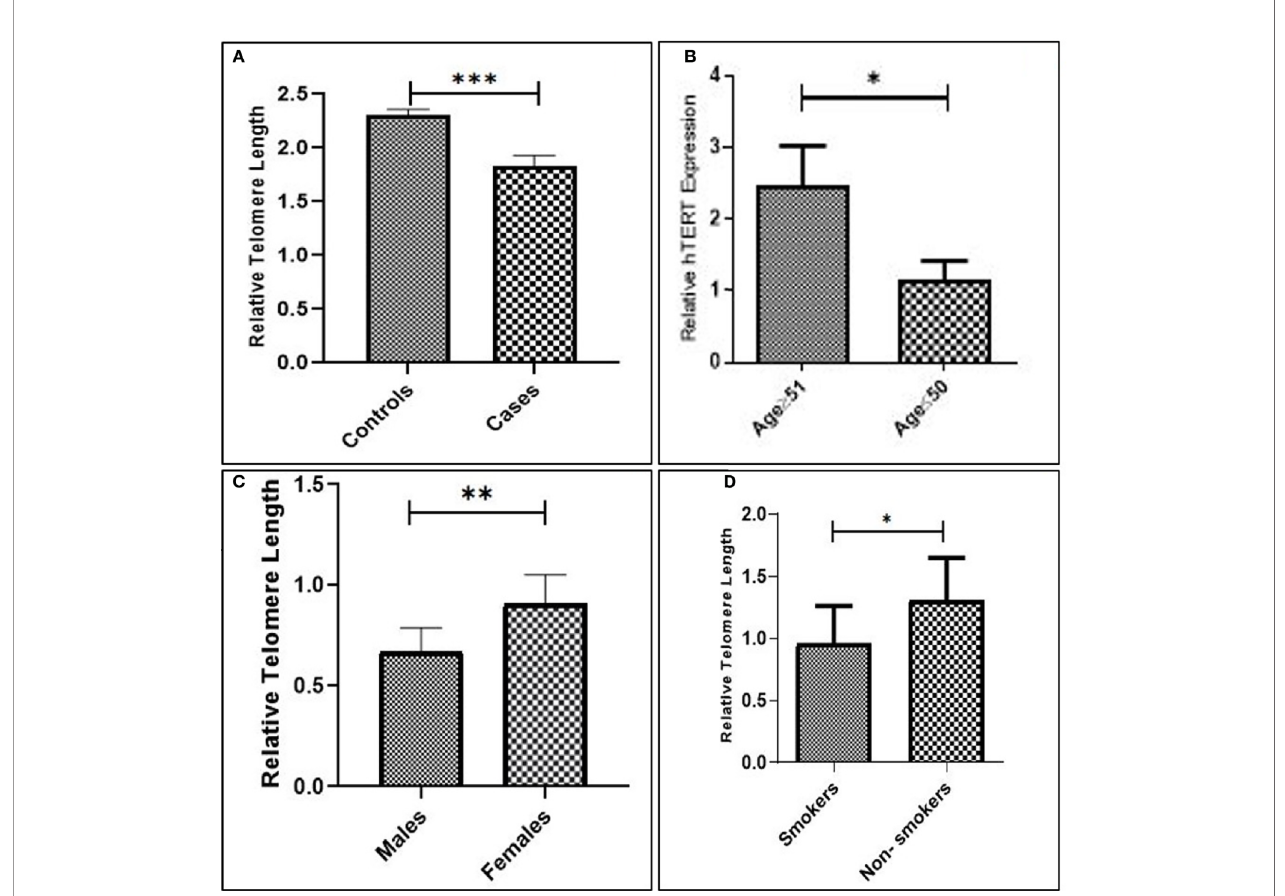
FIGURE 4 | (A) Relative telomere length among cases and controls. (B) Advanced age. (C) Males compared to females. (D) Smokers compared to